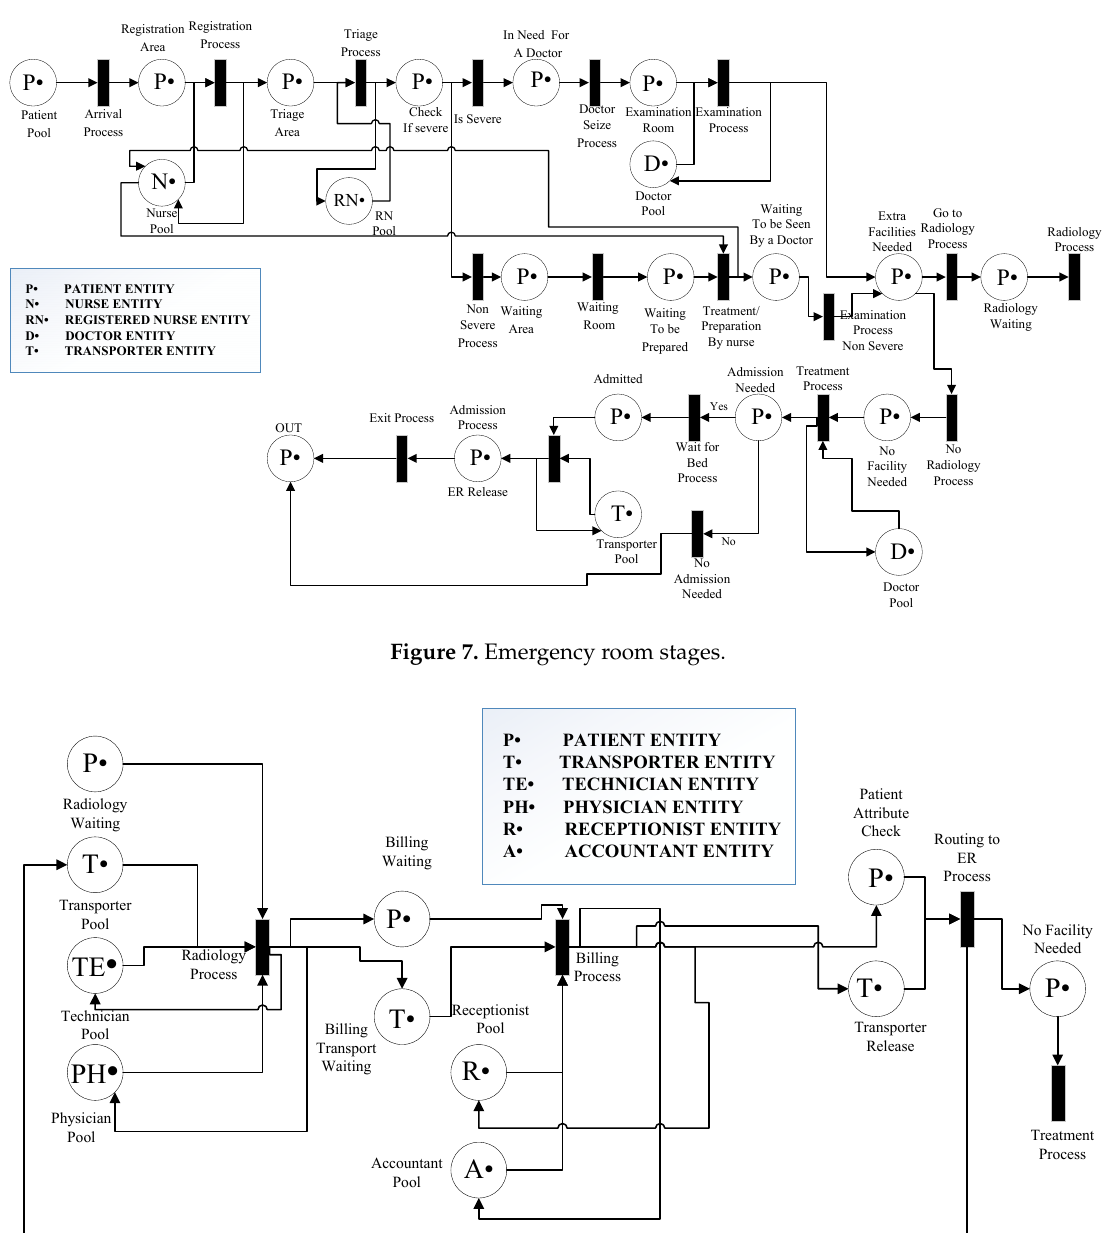
Figure 8. Petri net radiology/billing.